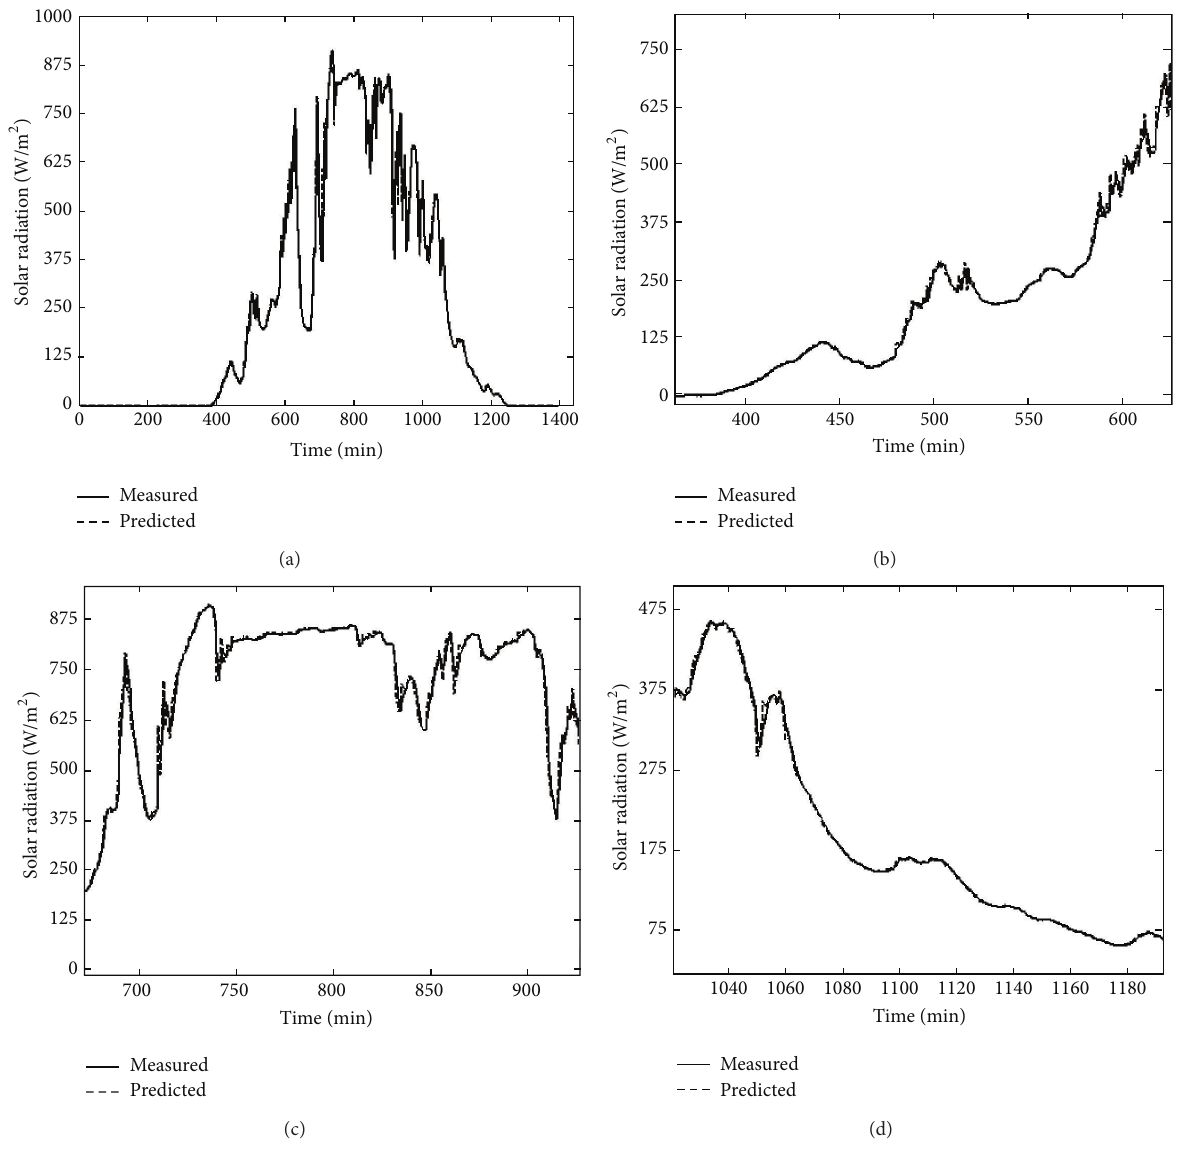
Figure 8: One-step ahead prediction for one day of solar radiation using a MARM with 𝑚 = 3 and 𝑝 = 4 . (b), (c), and (d) represent zoomed images of